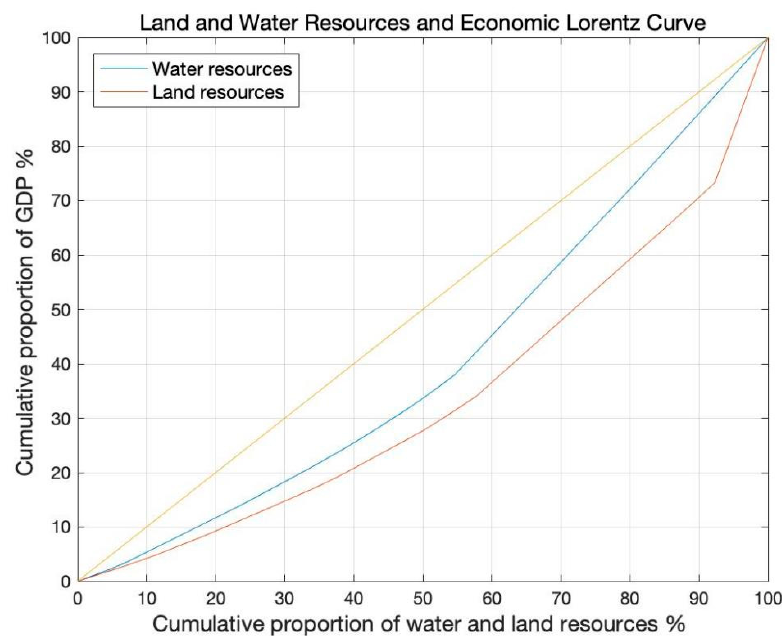
Figure 6. Water resources, land resources and GDP Lorenz curve in the Chengdu–Chongqing Economic Circle in 2018.